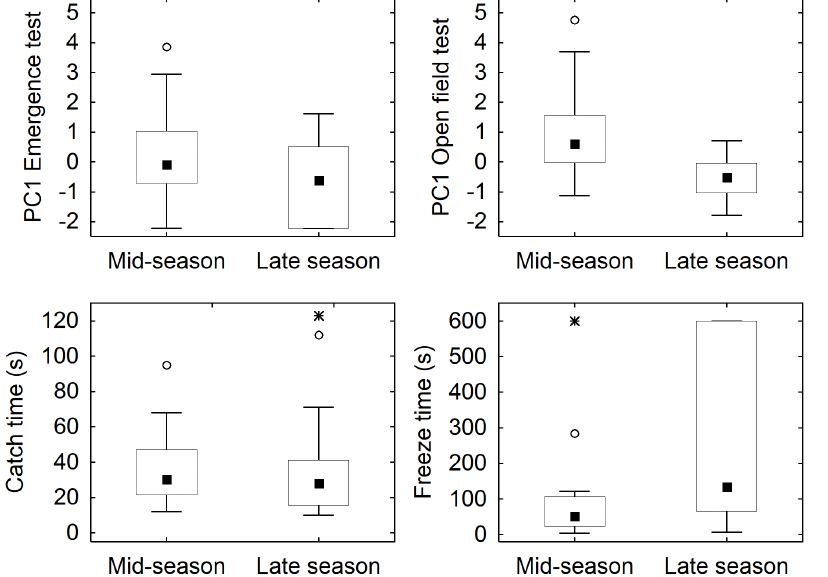
Figure 4. The effect of time of season and run order on boldness in two-spotted goby males. a) Boldness scores (PC1) from the emergence test, b) Boldness scores (PC1) from the open field test, c) Catch time (s), and d) Freeze time (s). Boxplots show median, quartiles, and non- outlier range.